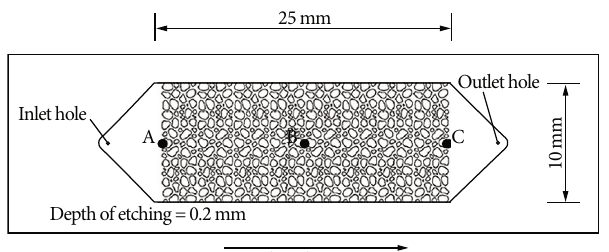
Figure 1: Schematic of a micro fl uidic porous chip.